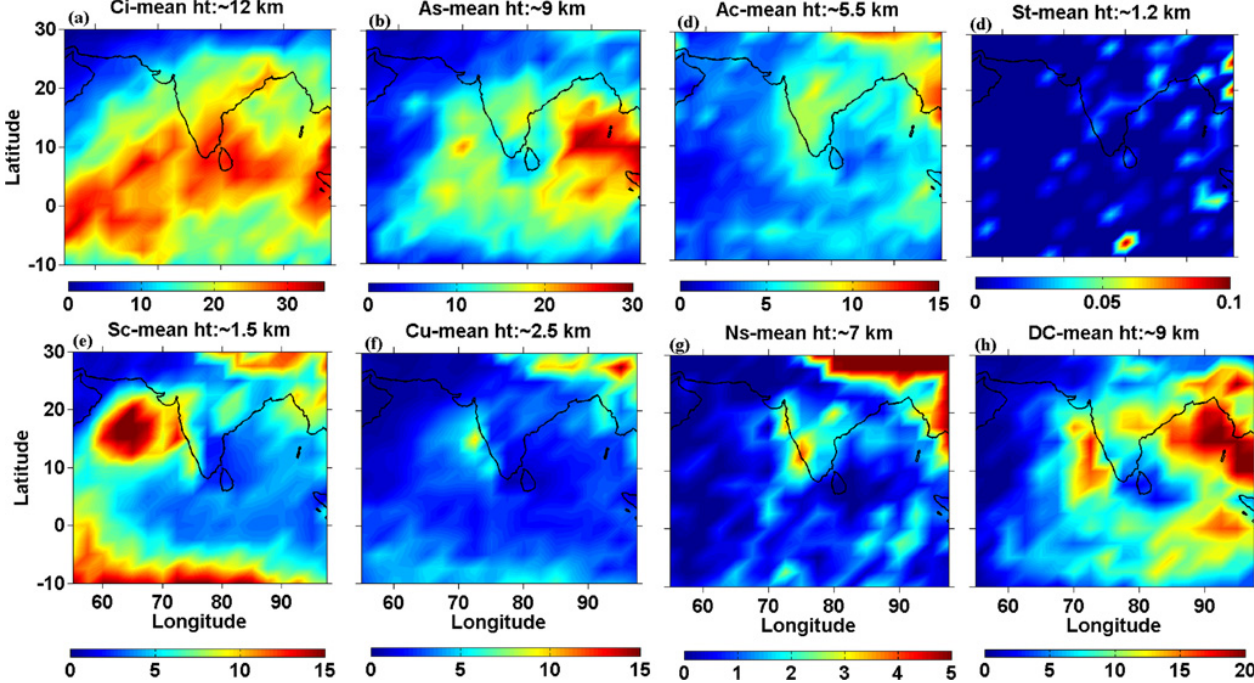
Fig. 1. Five-year (2006–2010) mean distribution of frequency of occurrence during JJAS of (a) Ci, (b) As, (c) Ac, (d) St, (e) Sc, (f) Cu, (g) Ns and (h) DC clouds over the ISM region. Both day- and nighttime observations of CloudSat are used for the analysis. The mean altitude provided at the top of the maps corresponds to the average of peak altitudes at which maximum frequency of occurrence is observed over the study region (see text for more